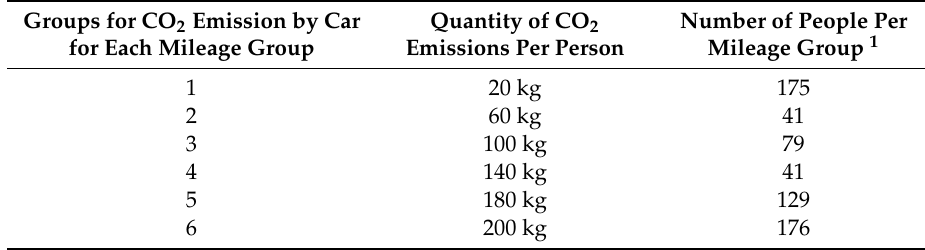
Table 3. The Quantity of CO 2 Emissions Generated per Person and Total per Mileage Group that Drove a Car